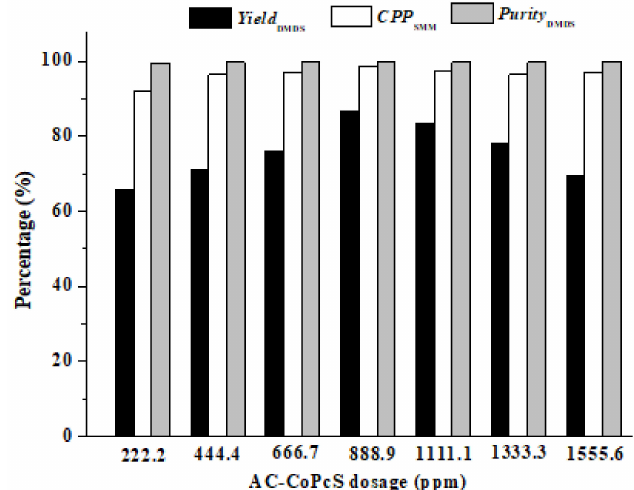
Figure 8. The effect of AC-CoPcS catalyst dosage on CPP SMM , Yield DMDS , and Purity DMDS . Experimental conditions: SMM (18.0 wt%) 450 g, RR = 600 r/min, t = 60 min, T re = 65 ◦ C, P (O 2 ) = 0.9